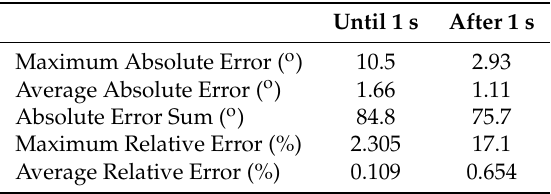
Table 4. Motor First and Second Order Models Errors